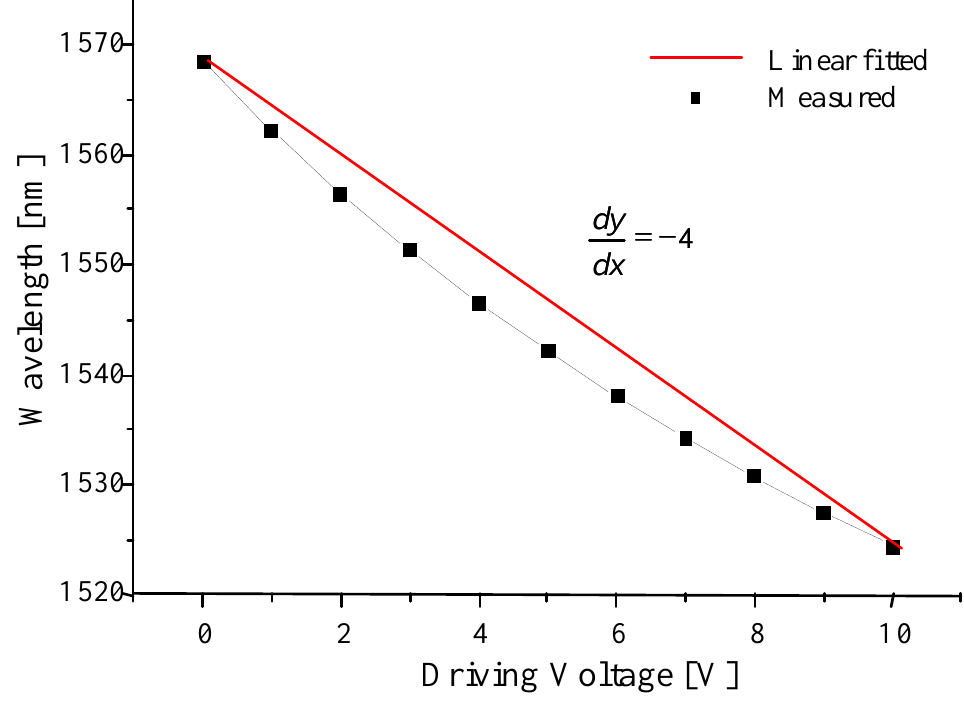
Figure2. The nonlinear wavelength tuning of the MEMS FP-TF